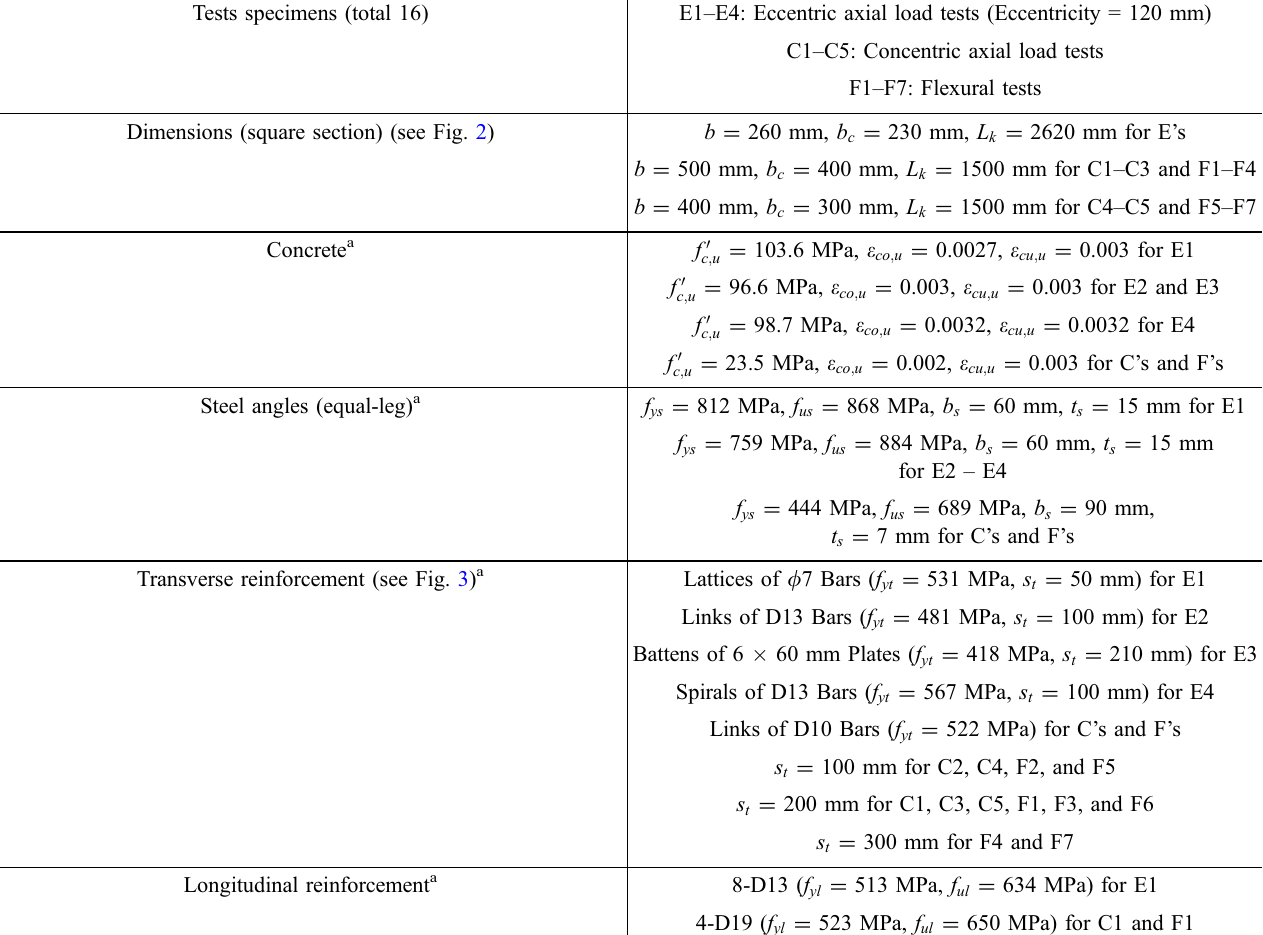
Table 1 Material and geometric properties of previous test specimens (Kim et al. 2014, 2017; Eom et al. 2014; Hwang et al. 2016). Tests specimens (total 16)